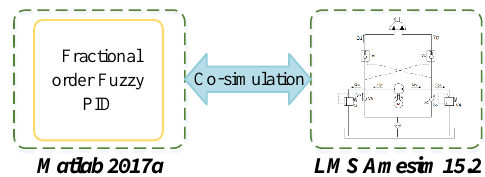
Figure 6. Communication between the system dynamic and the proposed controller.